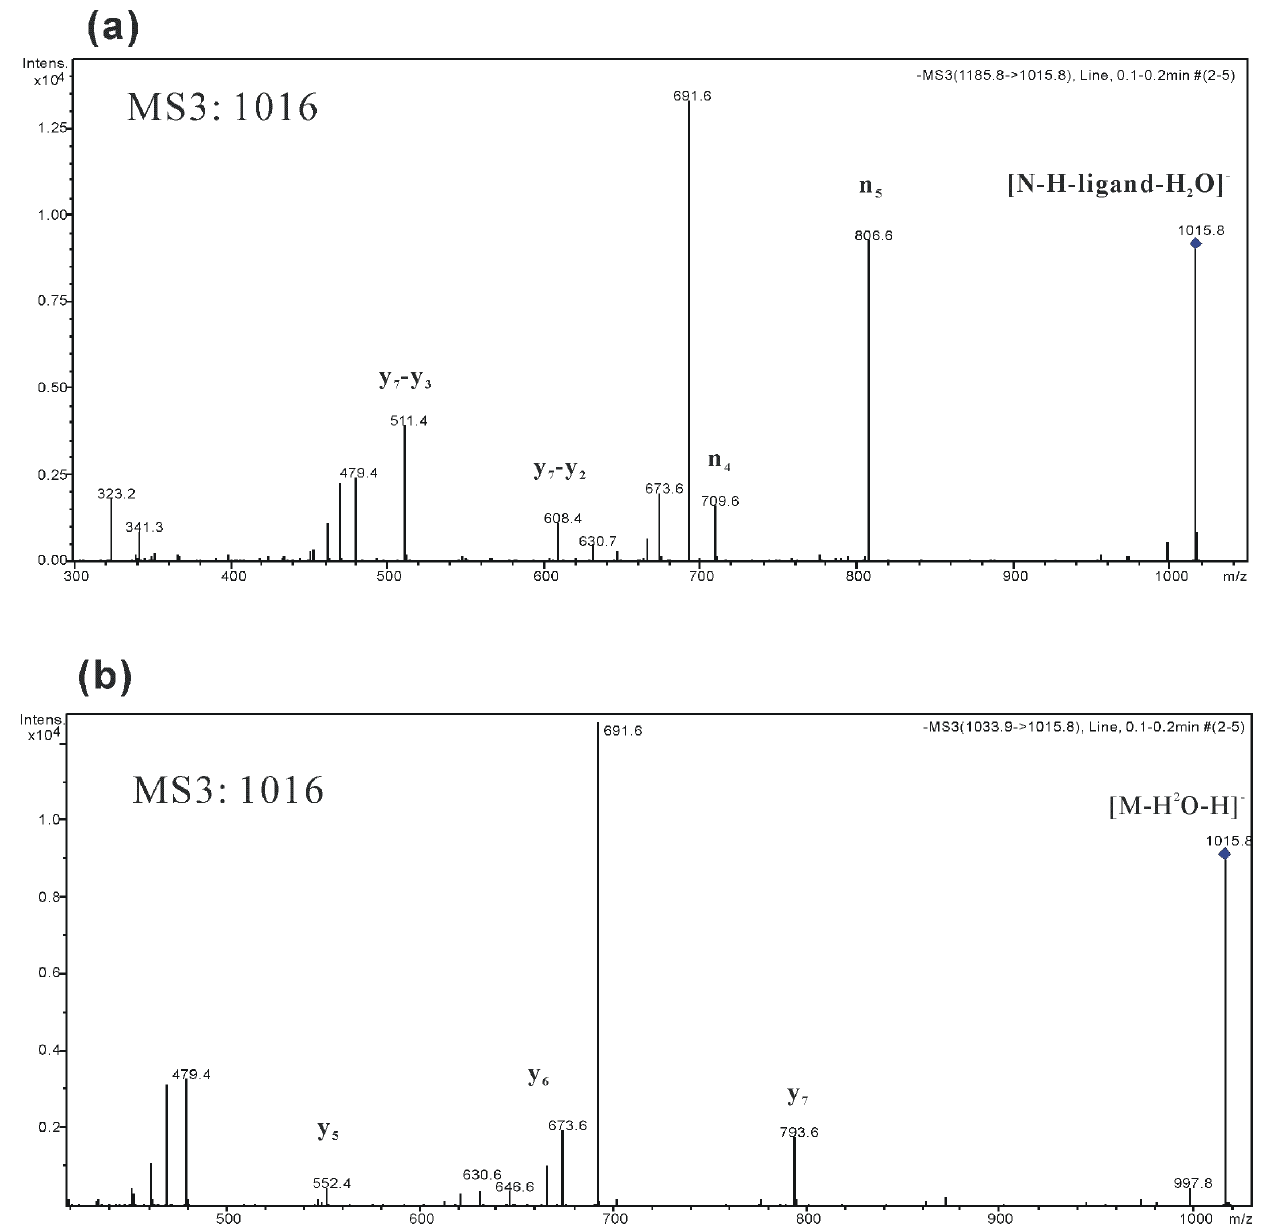
Figure 3. The MS 3 fragmentation of 1016 Th ions of non-covalent complex (a) and lichenysins G (b).